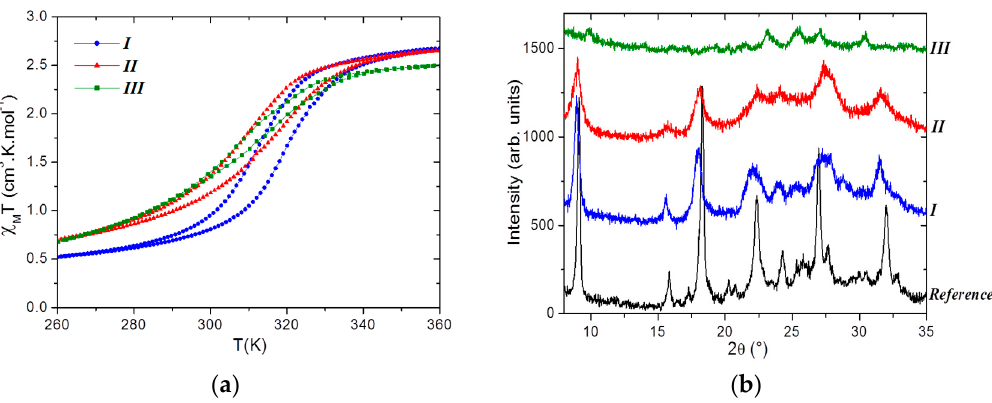
Figure 3. Physical characterizations of batches I (blue), II (red), and III (green) showing ( a ) χ M T as a function of temperature and ( b ) the powder X-ray diffraction (PXRD) patterns, including the reference one for [Fe(NH 2 trz) 3 ]Br 2 ·nH 2 O. Note that while not fully indexed, the latter corresponds to the hexagonal unit-cell with a = b = 19.653(2) Å and c = 7.371(1) Å [23].